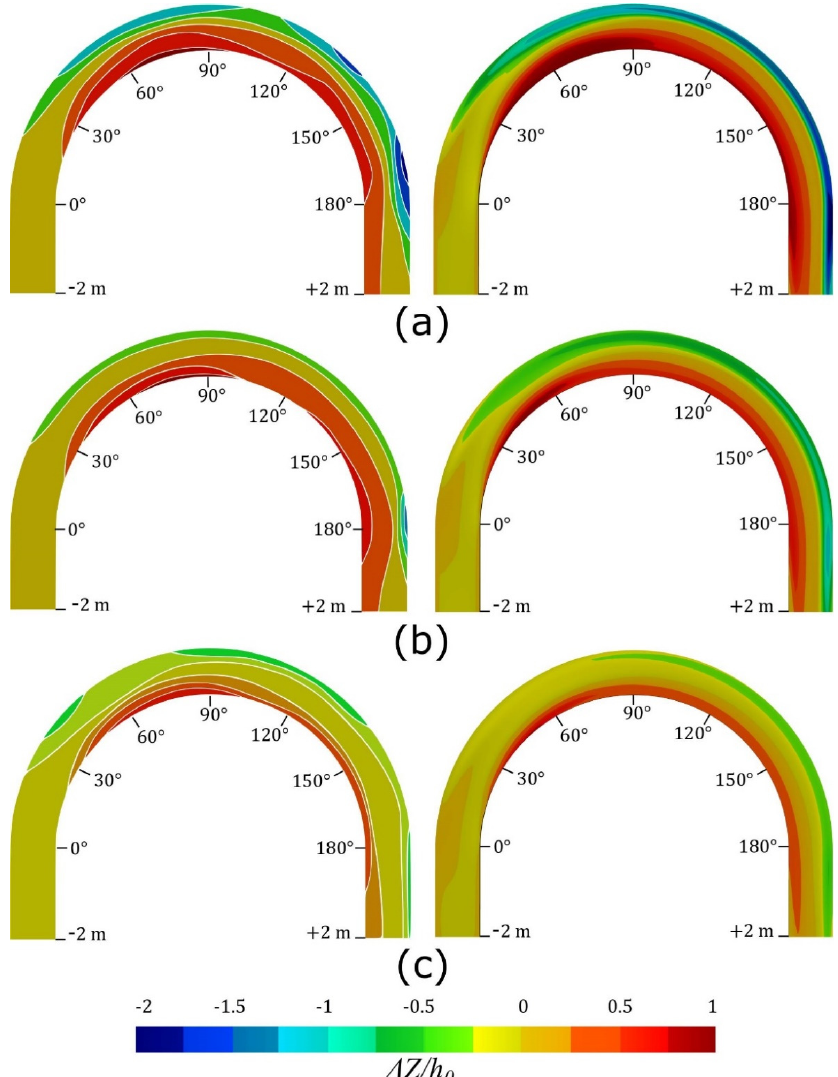
Figure 5. Plan view of the normalized bed deformations for ( a ) Run#1, ( b ) Run#3, and ( c ) Run#5, comparing the simulations ( right ) to the measurements ( left